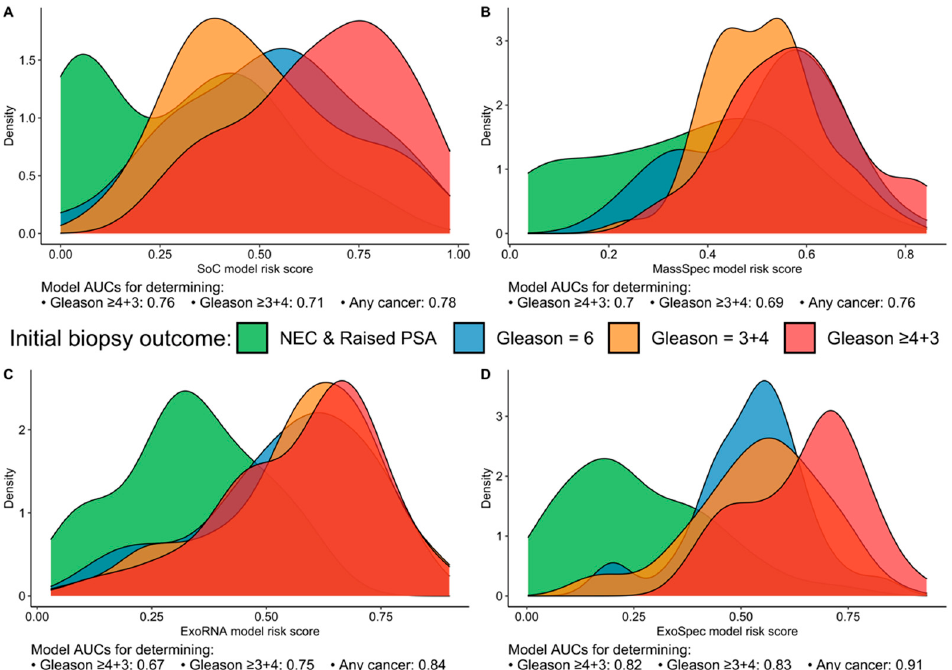
Cancers 2022 , 14 , x FOR PEER REVIEW 10 of 18